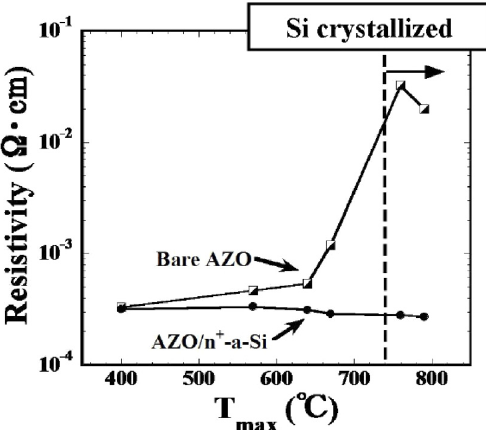
Fig. 1. Resistivity vs. maximum surface temperature T max of AZO films with and without a 30-nm-thick n + -a-Si capping layer after TPJ annealing.